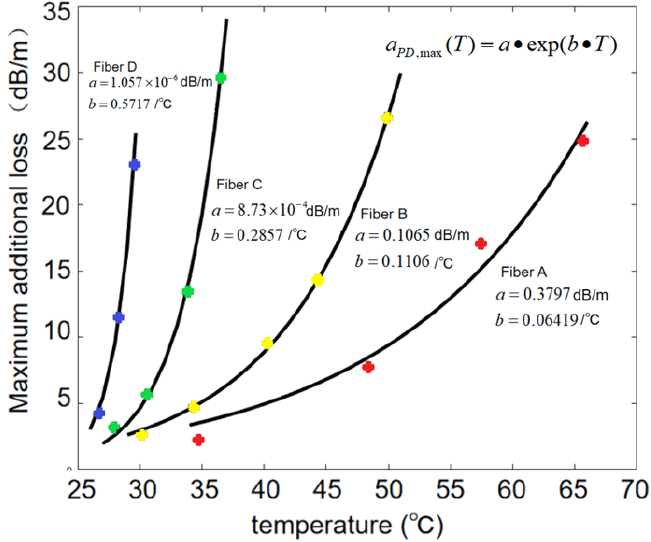
Figure 8. Relationship between core temperature and maximum additional loss. a and b in the figure is the fitting